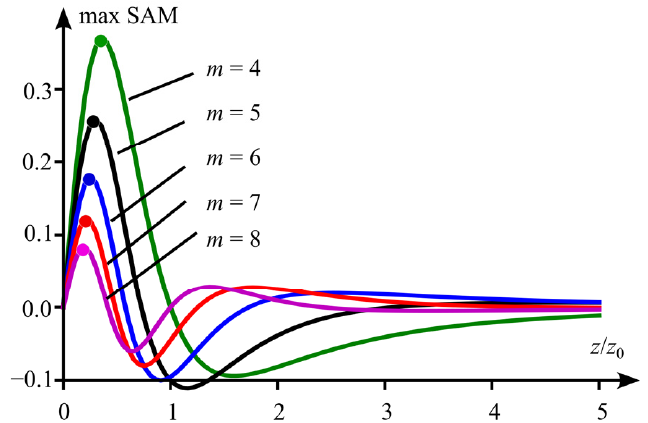
Figure 7. Maximal SAM for several numbers of the polarization singularities m when the singularities circle radius is chosen so as to equalize the intensities in the center and in the periphery. Dots in the top of each plot indicate the maximal-SAM distance obtained by the approximate Formula (33).